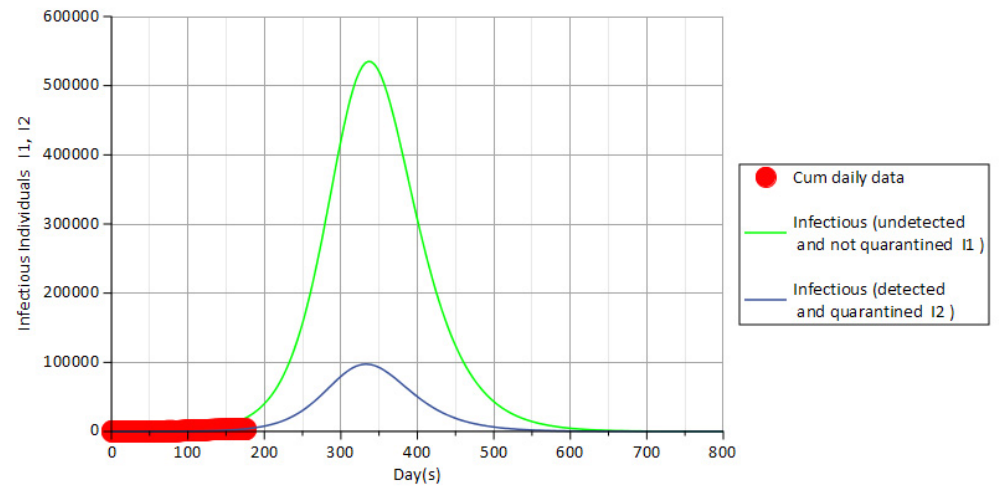
Figure 6. Effect of mass media value σ m = 0.55 with cumulative daily infectious individuals (red), I 1 ( t ) (green) and I 2 ( t ) (blue) using other parameters as in Table 3